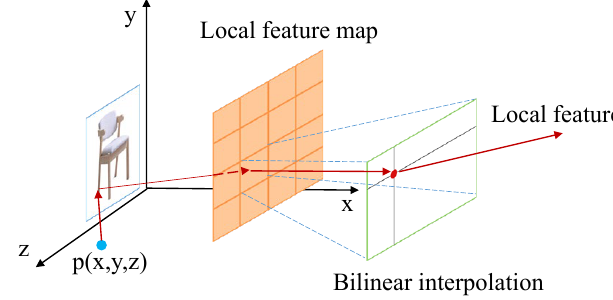
Figure 4. Local feature extraction.